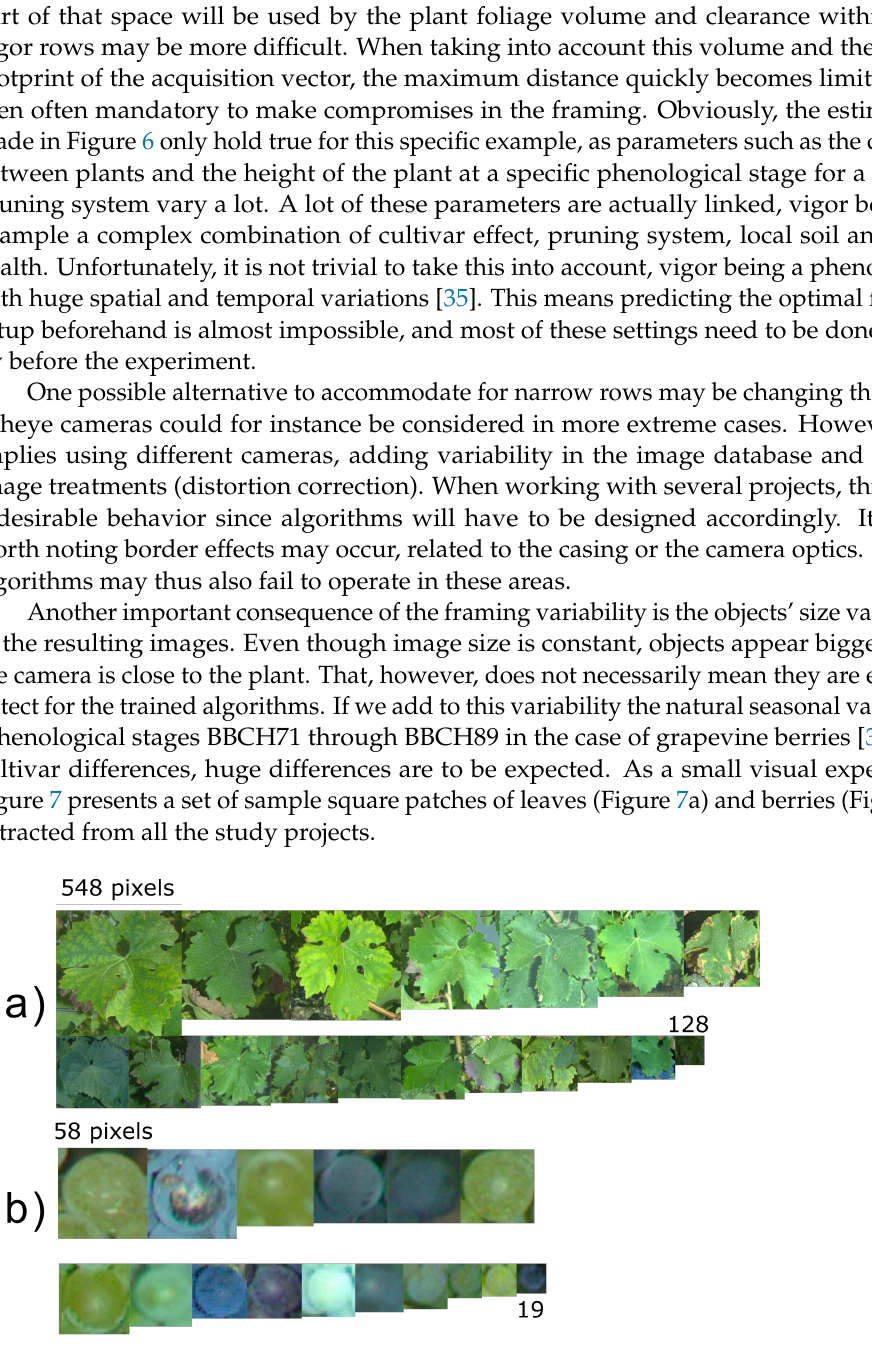
Figure 7. Samples of leaf ( a ) and berry patches ( b ) in the databases from the 4 study projects. Numbers indicate for each category the minimum and maximum square patch size in the batch. Original full images were all of size 2448 × 2048